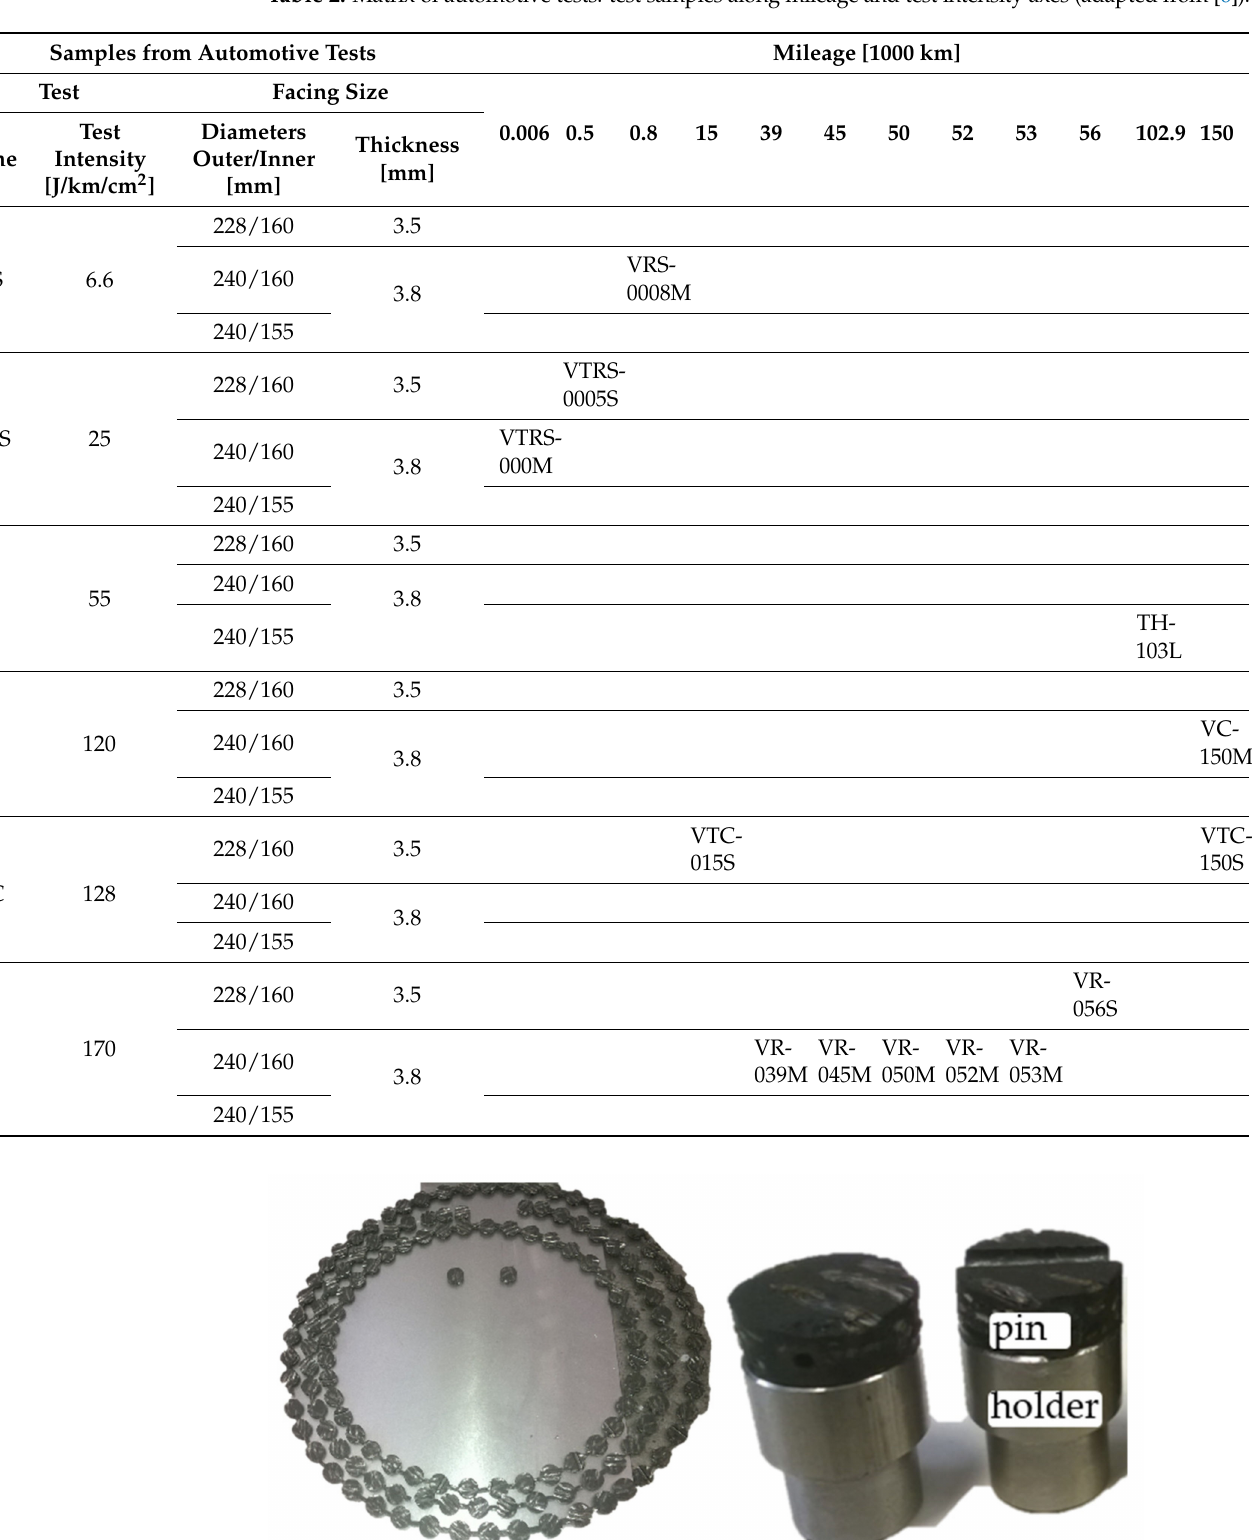
Table 2. Matrix of automotive tests: test samples along mileage and test intensity axes (adapted from [6]).